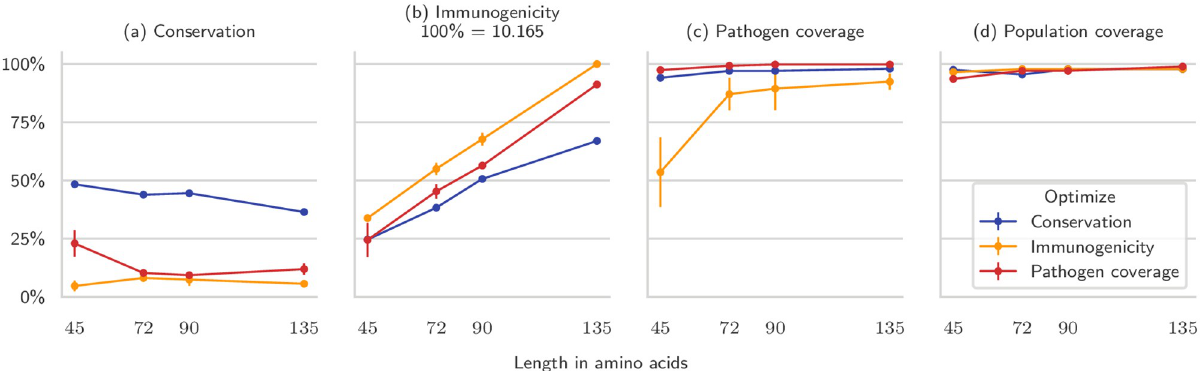
Fig 8. Comparison of mosaic vaccines optimized for different objectives. Here we designed mosaics of varying amino acid length (on the x axis) while optimizing for conservation (blue), immunogenicity (red), and pathogen coverage (yellow). The plots compare the vaccines in terms of conservation (a), immunogenicity (b), pathogen coverage (c), and population coverage (d). For longer vaccines, optimizing for pathogen coverage only gives modest improvements on the mosaics optimized for immunogenicity in terms of coverage, and does not increase conservation by much. When optimized for, conservation is considerably higher but becomes harder to improve as the vaccine becomes longer, due to the fact that few epitopes are well conserved and highly immunogenic at the same time. Average of five runs, standard deviation on the error bars.